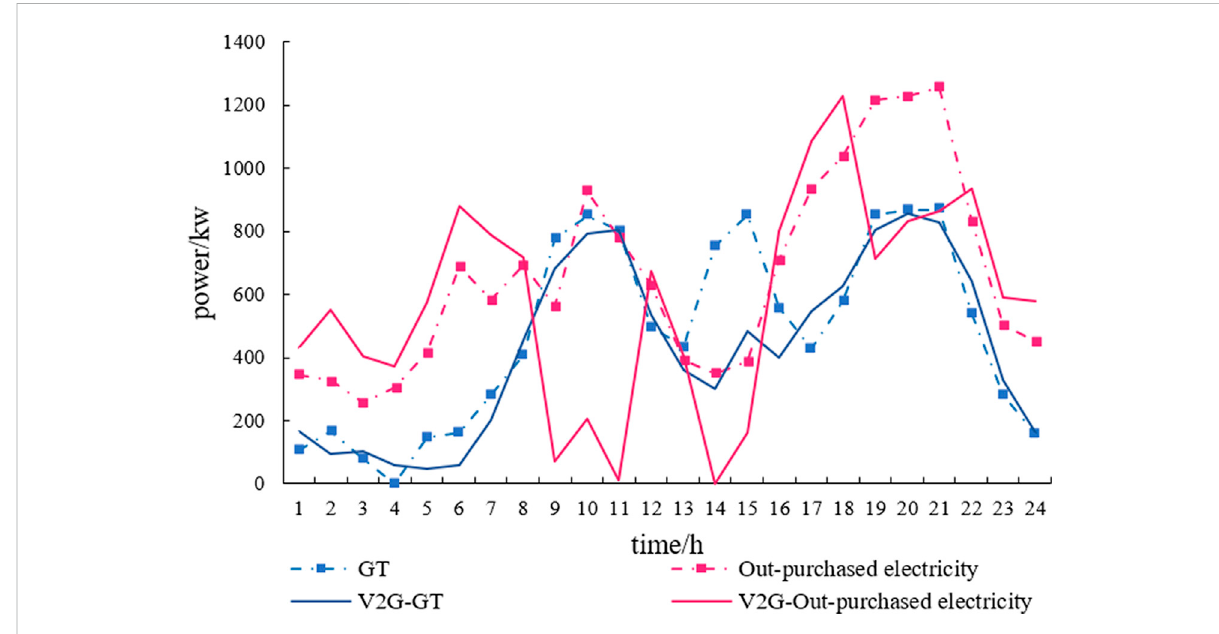
FIGURE 8 Comparison of GT output and purchased electricity before and after the system considers V2G.